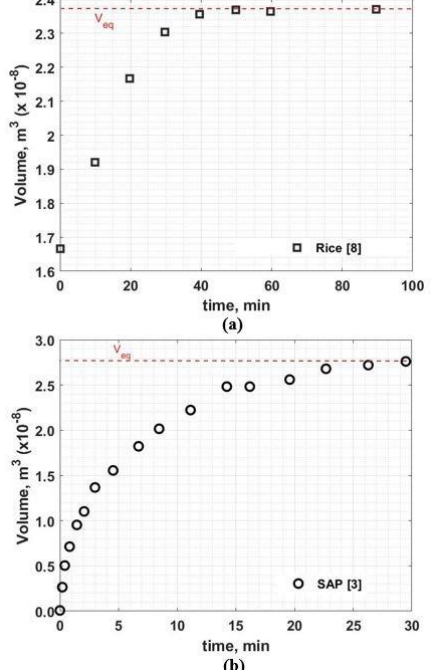
Fig. 1 Swelling of a single grain of (a) rice [8] and (b) SAP [3].